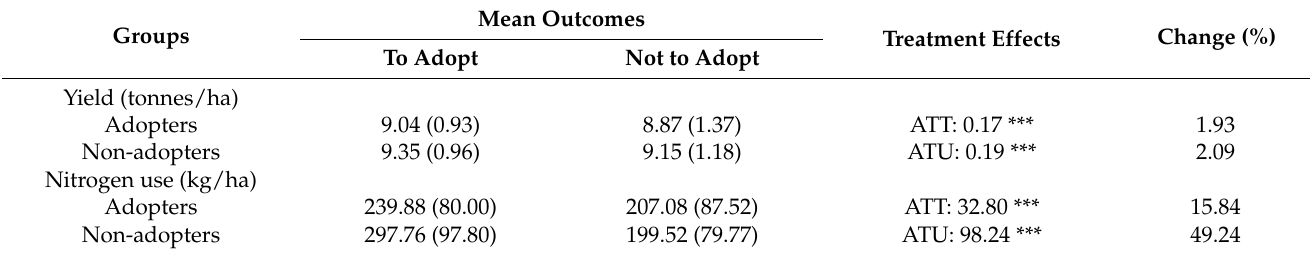
Table 7. Average treatment effects for the robustness